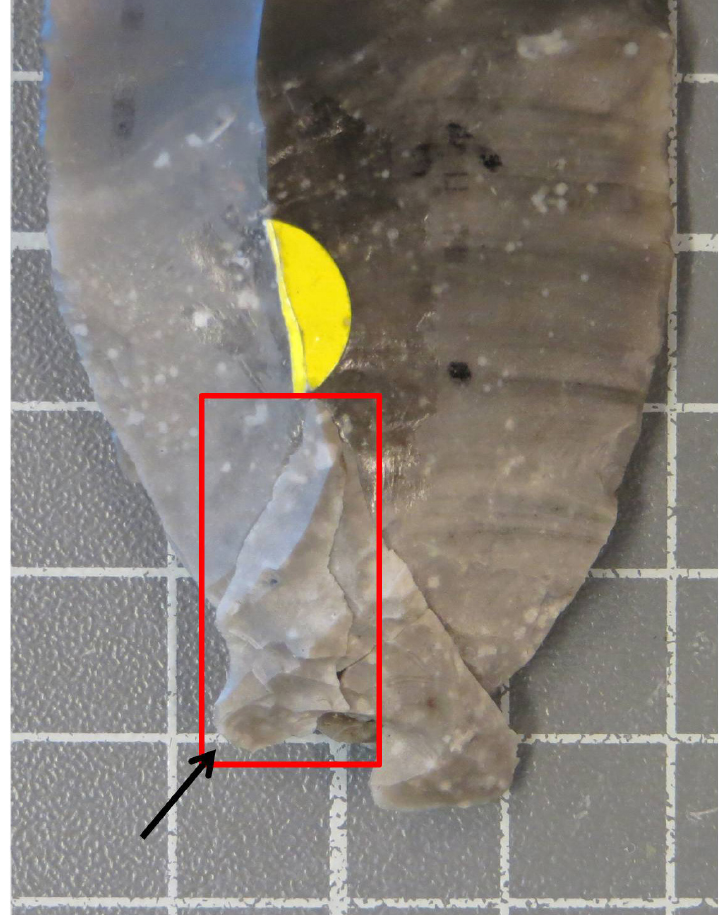
Figure 11. Blade-point 5.19, flake d2 with the black arrow indicating direction of the blow of removal (photograph by the author). Gridlines on this image are 10mm